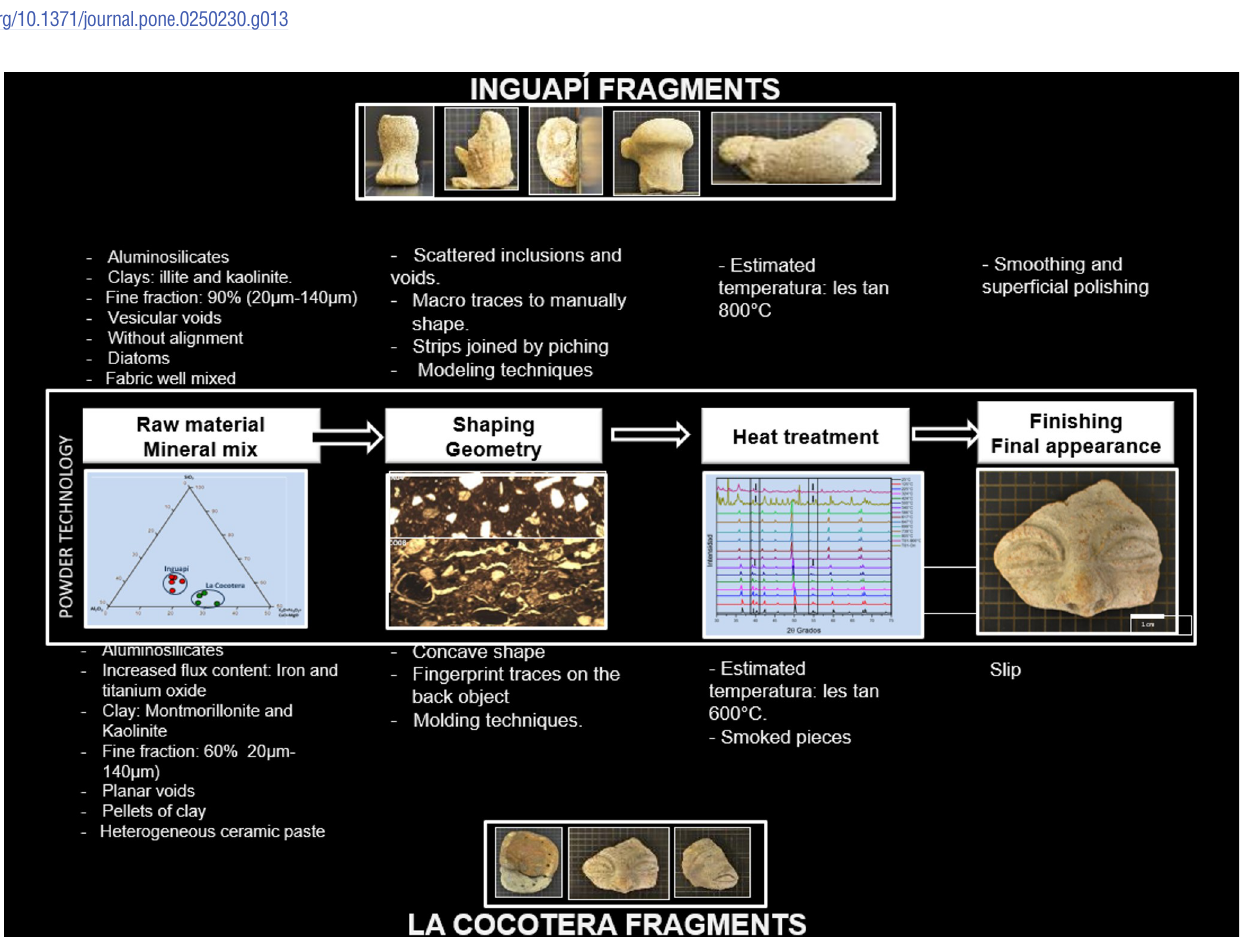
Fig 14. Differences in the manufacturing stages of ceramic figurines from the Tumaco archaeological tradition.